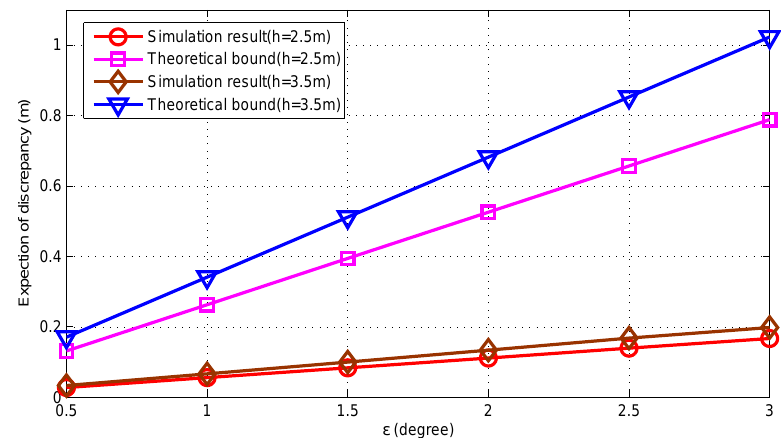
Figure 10. Performance analysis versus two big